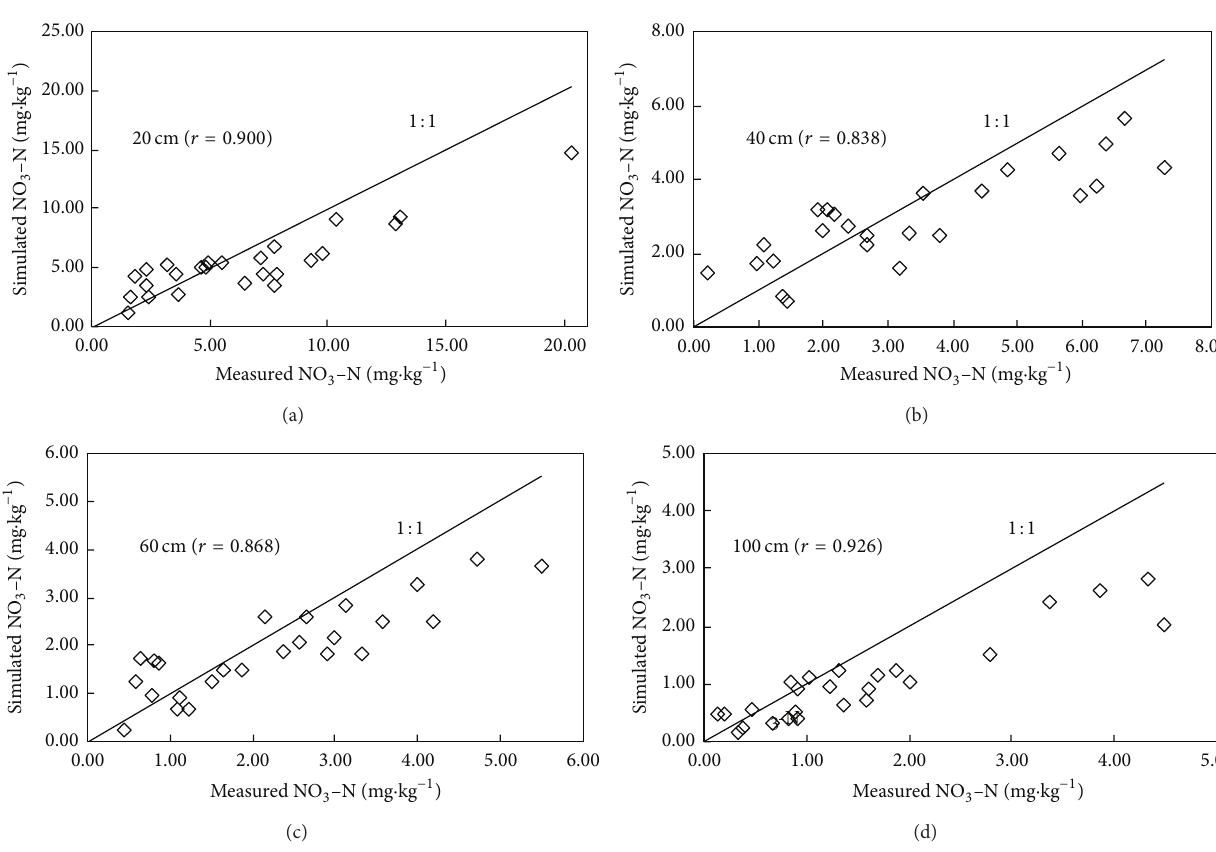
lands, respectively. The LEACHM model was found to